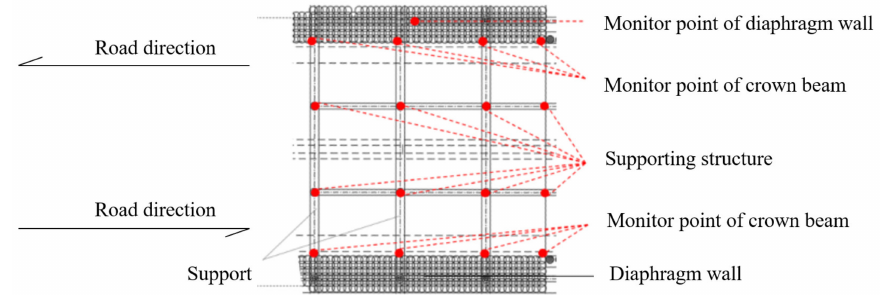
Figure 2. Layout of monitor